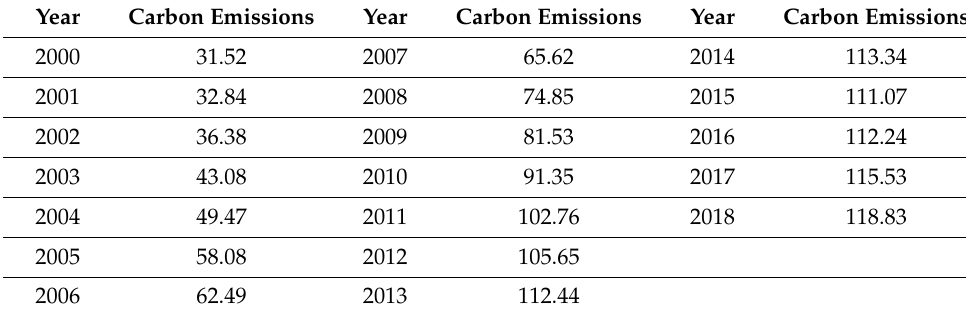
Table 2. Annual carbon emission data (the unit of carbon emission is 10 2 million